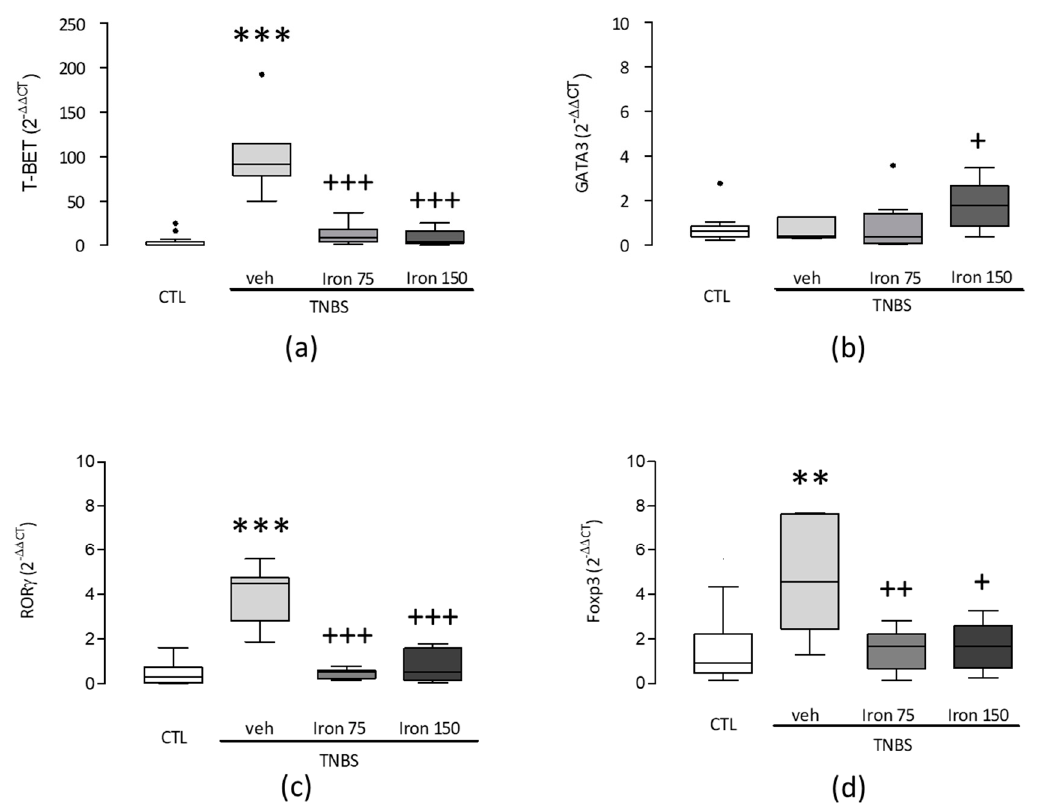
Figure 4. The impact of iron supplementation on the Tbet ( a ), Gata3 ( b ), ROR γ ( c ) and Foxp3 ( d ) gene expressions in the spleen. Data are expressed as a Tukey boxplot with a median. Each small black dot ( • ) represents individual data that is not included between the whiskers. **, *** significantly di ff erent ( p < 0.01 and p < 0.001, respectively) from the controls (CTL). + , ++ , +++ significantly di ff erent ( p < 0,05,